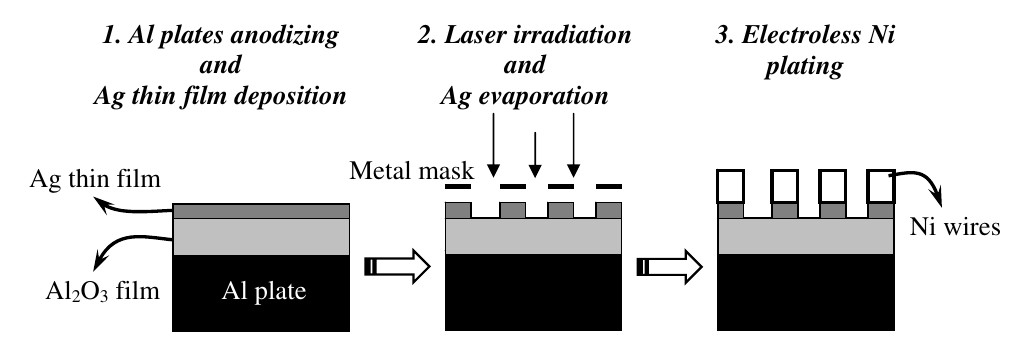
Fig. 1 The general steps scheme of Ag/Al 2 O 3 /Al system processing.